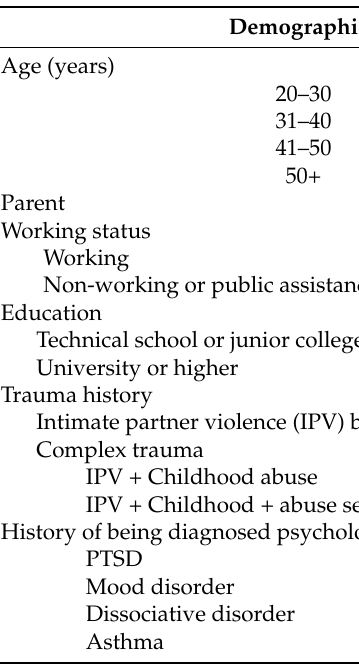
Table 1. Characteristics of survivors’ who achieved trauma integration.